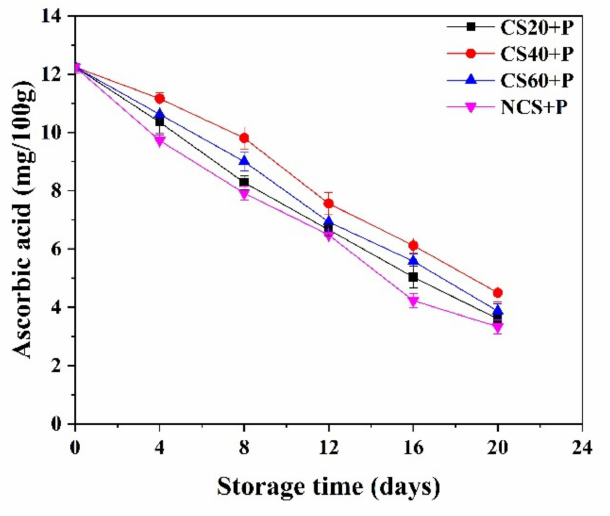
Figure 5. Effect of different treatments on the ascorbic acid content of cucumbers during storage at 13 ± 2 ◦ C. CS20+P − packaged after 20 min of cold shock; CS40+P − packaged after 40 min of cold shock; CS60+P − packaged after 60 min of cold shock; NCS+P − packaged after 0 min of cold